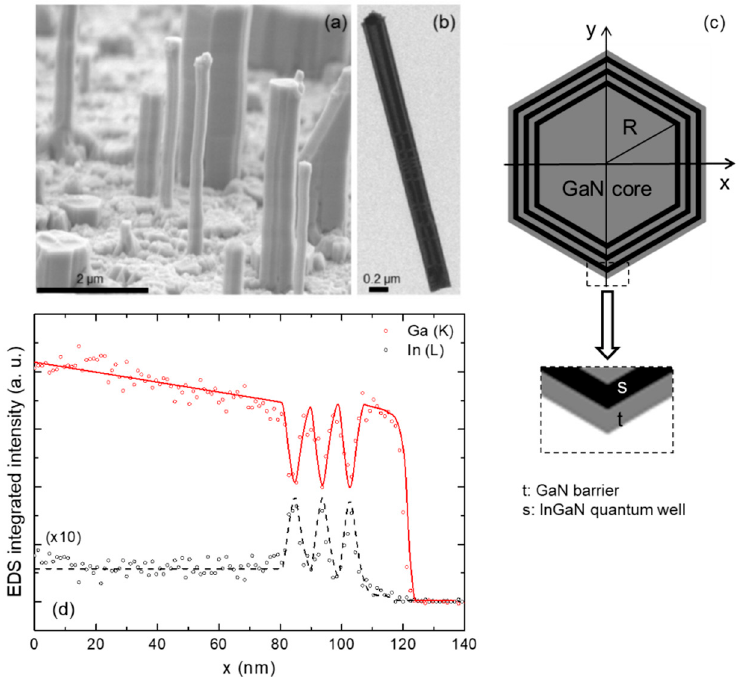
Figure 1. ( a ) SEM view of the as-grown nanowires (NWs) of the sample characterized in this study. ( b ) high resolution transmission electron microscopy (HR-TEM) of the single dispersed NW scanned by energy-dispersive X-ray spectroscopy (EDS). ( c ) Scheme of the cross-section of the core-shell GaN/InGaN NW and the magnification of its upper corner where t and s are the thickness of the InGaN quantum wells (QWs) and the GaN barriers, respectively. ( d ) Radial scans of the integrated intensities of the In L α and Ga K α peaks of the EDS spectrum taken at the top of the NW. The lines are the corresponding fitting curves.